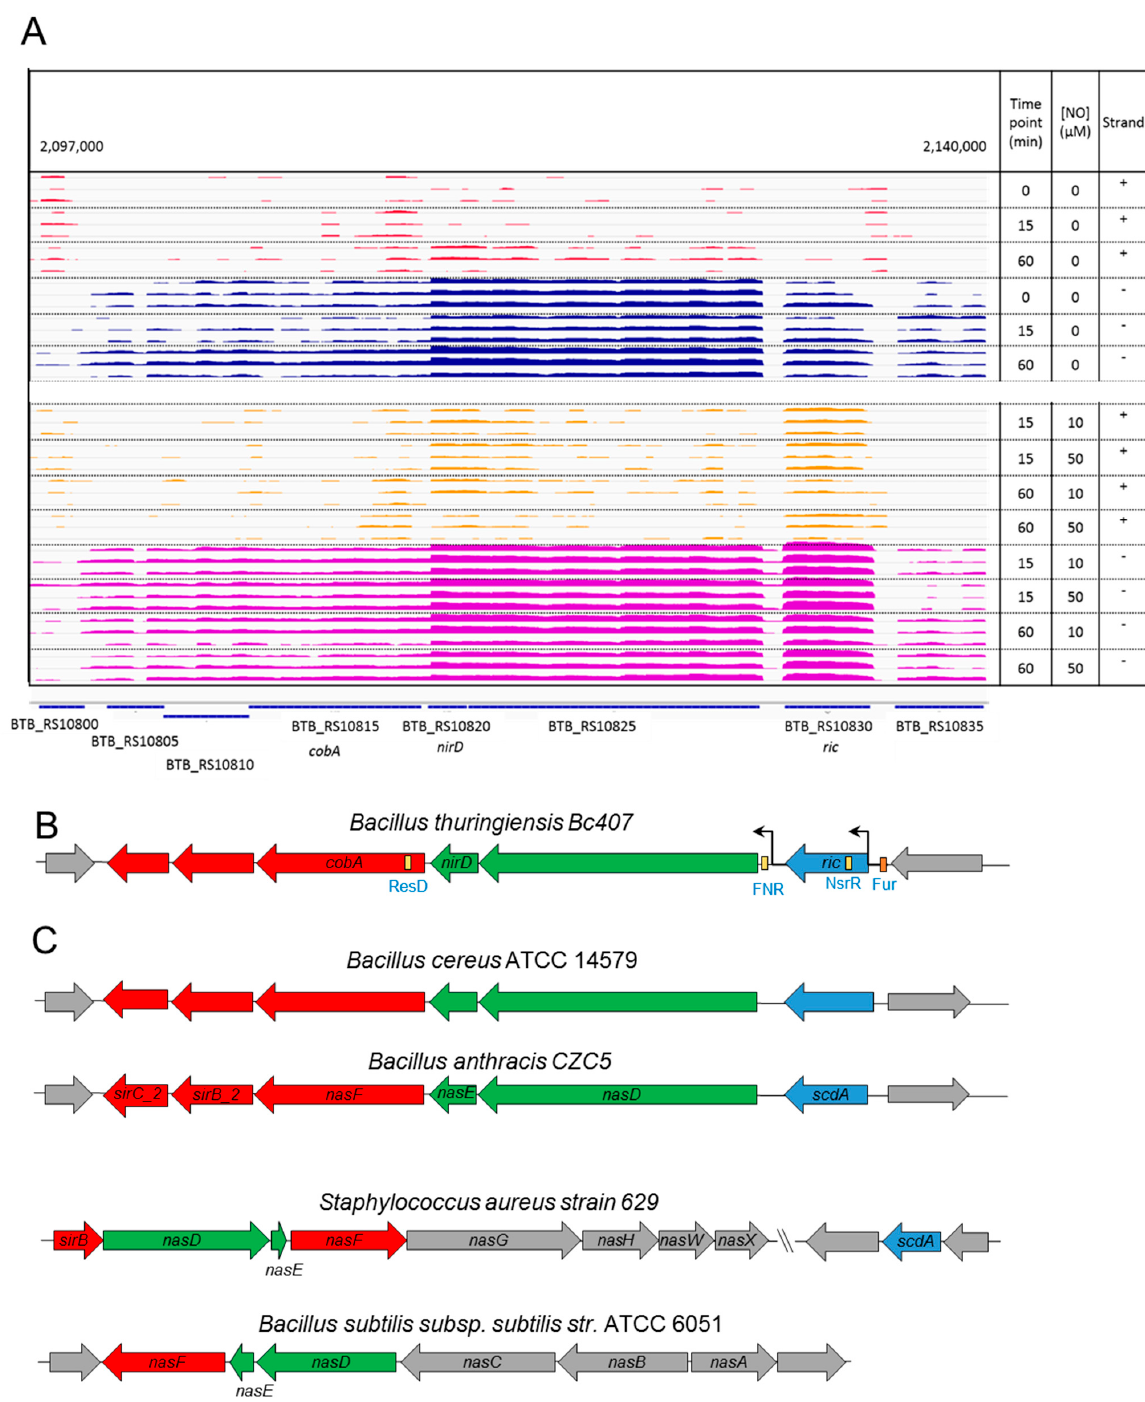
Figure 4. Organization and expression of the 6 genes of the BTB_RS10830-BTB_RS10805 region. ( A ) Quantification of transcription along the region. Representation of the number of pairs of reads (mRNA fragments) overlapping each position of the positive strand (red and yellow) and negative strand (blue and purple). Each colored area corresponds to one replicate in one condition: without NO (red and blue) or with NO (yellow and purple). The last line is the gene annotation of the reference strain Bacillus cereus Bc407 (NC_018877.1). ( B ) Schematic representation of the organization of the region in Bc407 chromosome (not to scale). The yellow boxes indicate the putative presence of regulatory binding regions. The black arrows indicate putative promoters. ( C ) Organization of the region in other Firmicutes species. The genes in grey do not belong to the 6 genes of the BTB_RS10830-BTB_RS10805